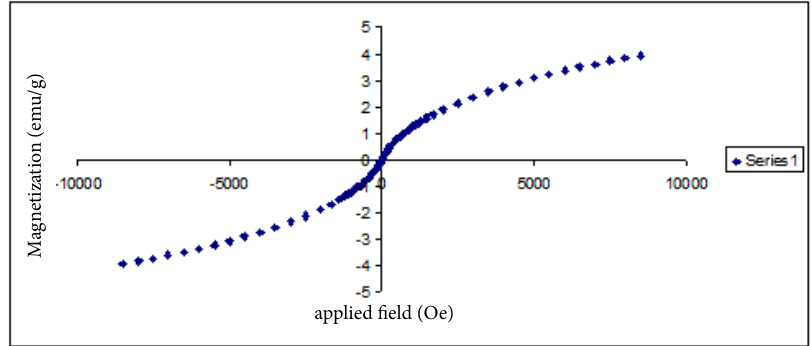
applied field Fig. 4. Magnetization vs. applied magnetic field for the prepared NFNs.